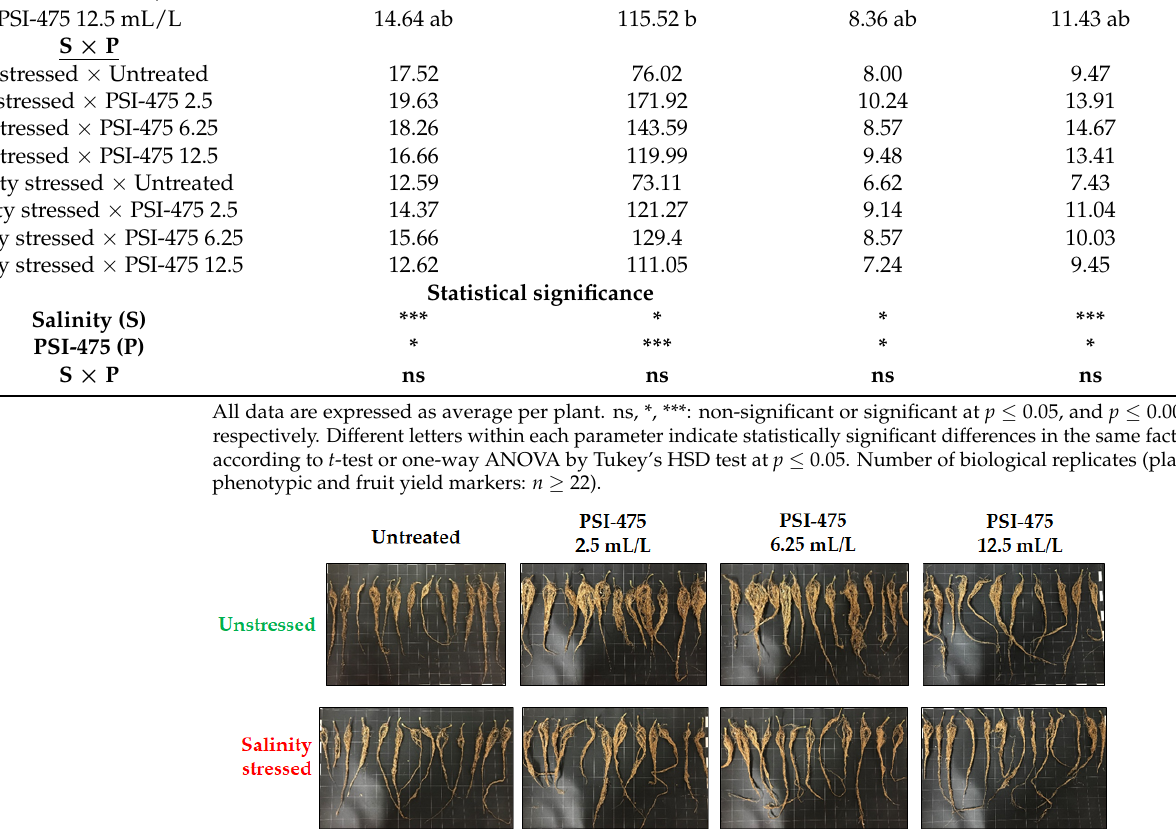
Figure 2. E ff ect of salinity and PSI-475 dosage rate on tomato fruit number and yield. Fruits shown in the pictures were harvested from 11 plants per treatment and condition. 2.2. E ff ect of Salinity and PSI-475 on Tomato Leaf RWC To determine the e ff ect of osmotic stress on tomato plants at harvest time, RWC in young leaf tissue was selected as a physiological marker in both untreated and treated plants with PSI-475 applied at 2.5 mL/L. The two-way ANOVA showed that both salinity stress and PSI-475 treatment were statistically signi fi cant, p = 0.026 and 0.011, respectively, with no signi fi cant interaction between both factors (S × P) (Figure 3). There was a signif- icant decrease of RWC between unstressed (80.27%) and salinity stressed (76.05%) condi- tions ( p = 0.026). The application of PSI-475 also positively a ff ected young leaf RWC, by increasing its average value by 3.3% compared to untreated plants in both unstressed and stressed plants.